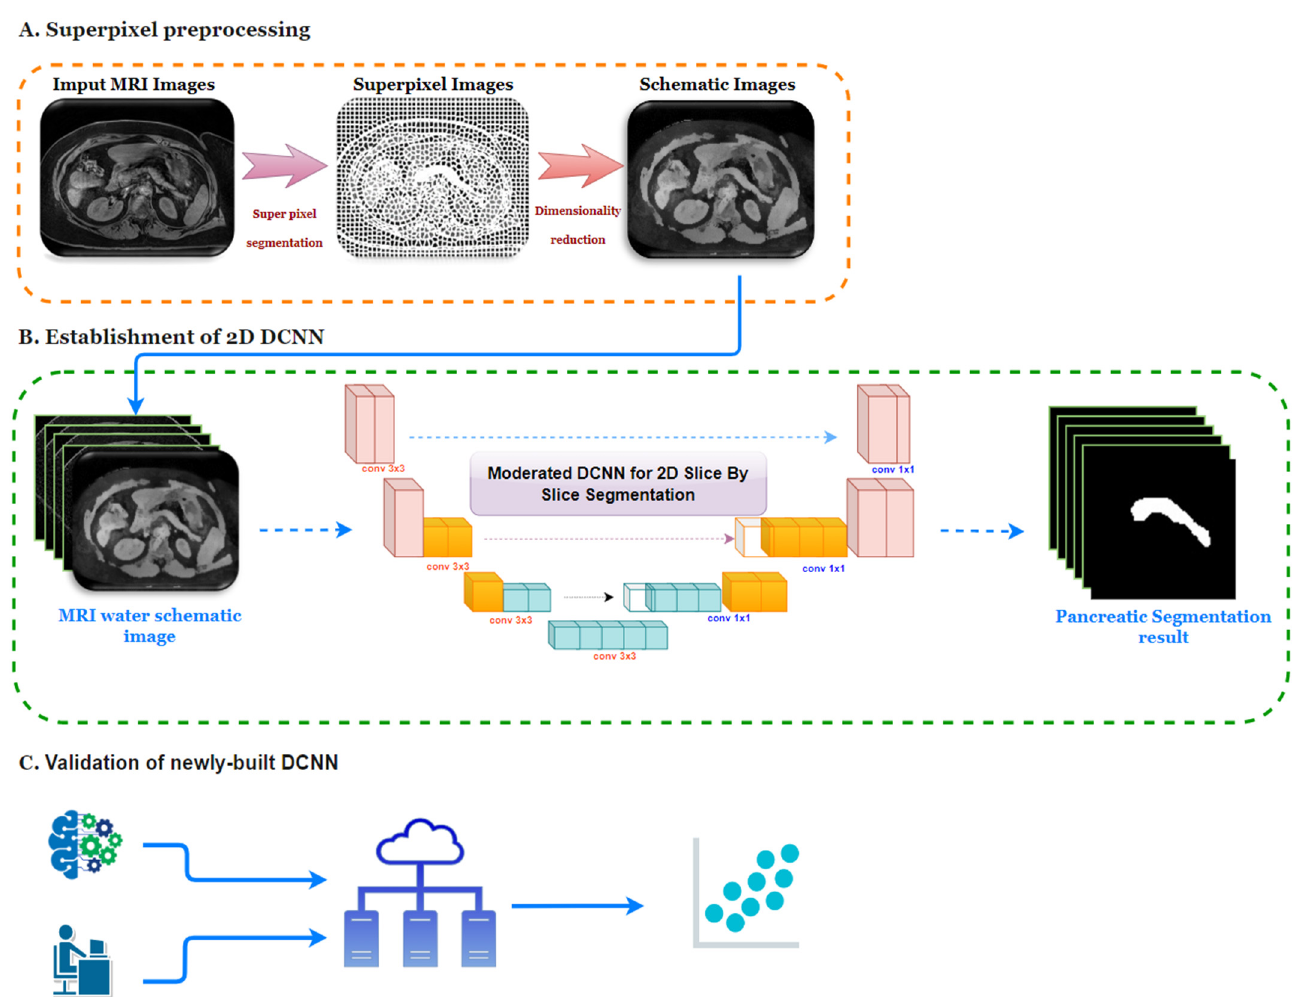
Figure 1. The overall workflow of the pancreatic segmentation. ( A ) MR images superpixel prepro- cessing; ( B ) 2D superpixel DCNN build-up via MR water images; ( C ) validation of the newly built DCNN with MRI obtained from 10 extra participants from the PAT study.